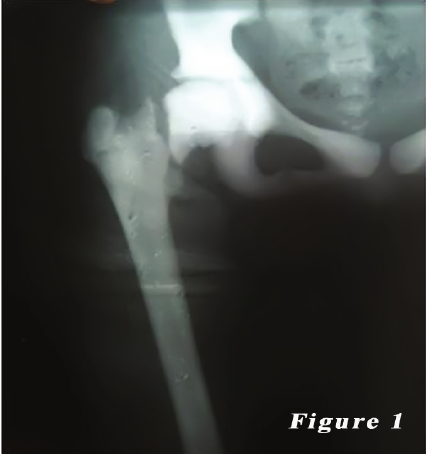
Figure 1: 14-year-old female patient (first case) preoperative radio- graphy of the right femoral neck fracture.